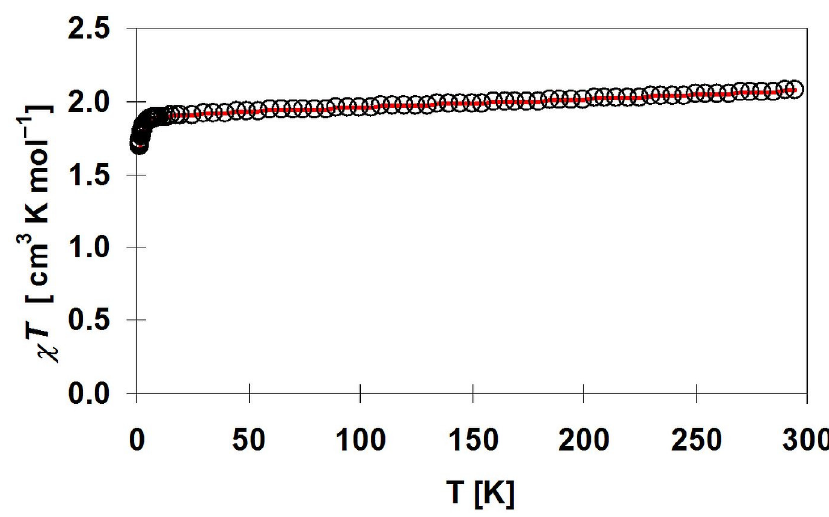
Figure 13. Thermal dependence of χ M T product for [{Cu II (trien)} 2 Ni(NCS) 6 Cu I (NCS)] n ( 2 ). The solid red line is the best fit for the model described in the text.